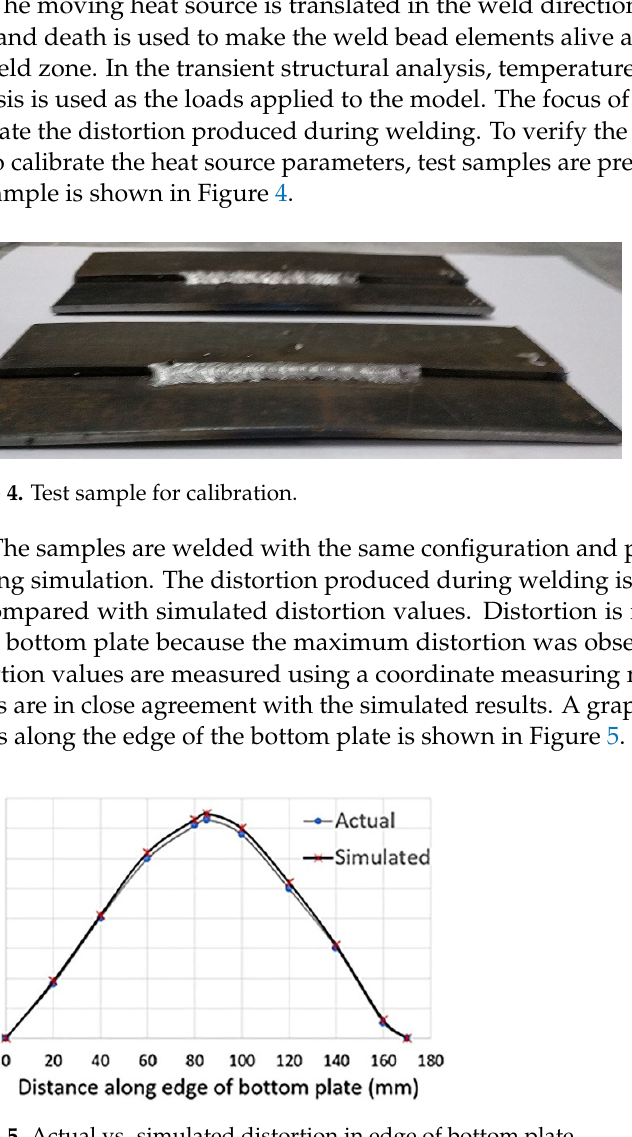
Figure 3. Finite element model of the sample plate.